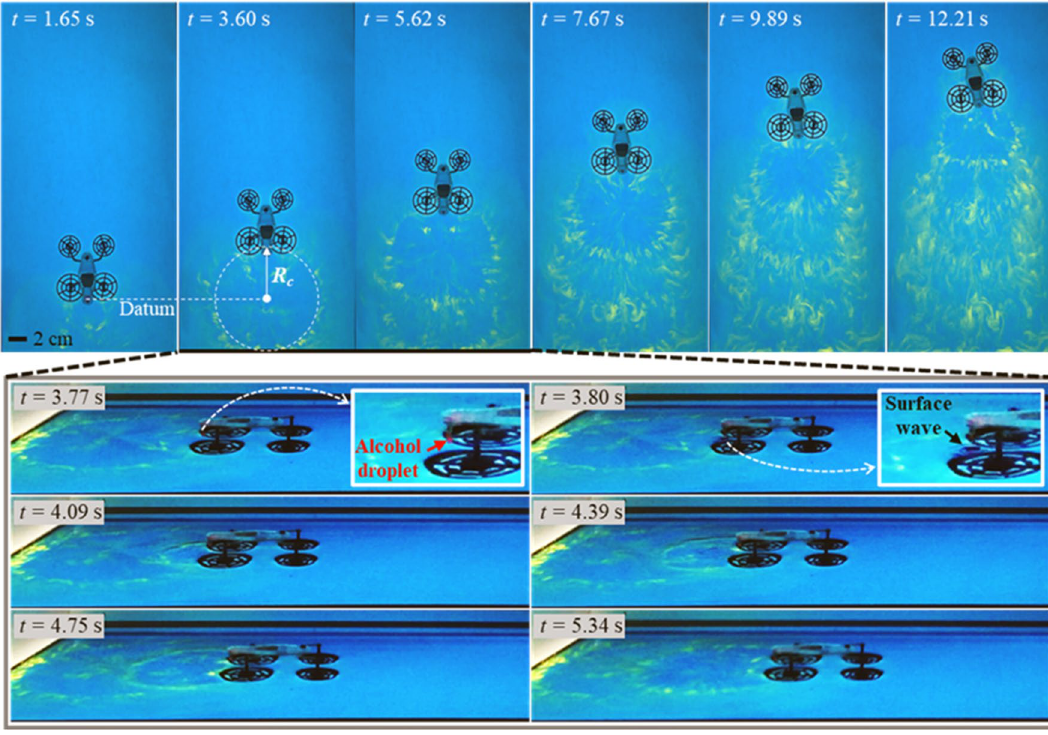
Figure 3. Marangoni flow visualization during propulsion. Top and side views of the robot propelled by the Marangoni effect; flow was visualized using BTB and other chemicals ( R c : ring trace radius). CP served as the porous medium. D O was 3.2 mm and h f was 9.5 mm; t is the time that elapsed after the first alcohol droplet broke from the